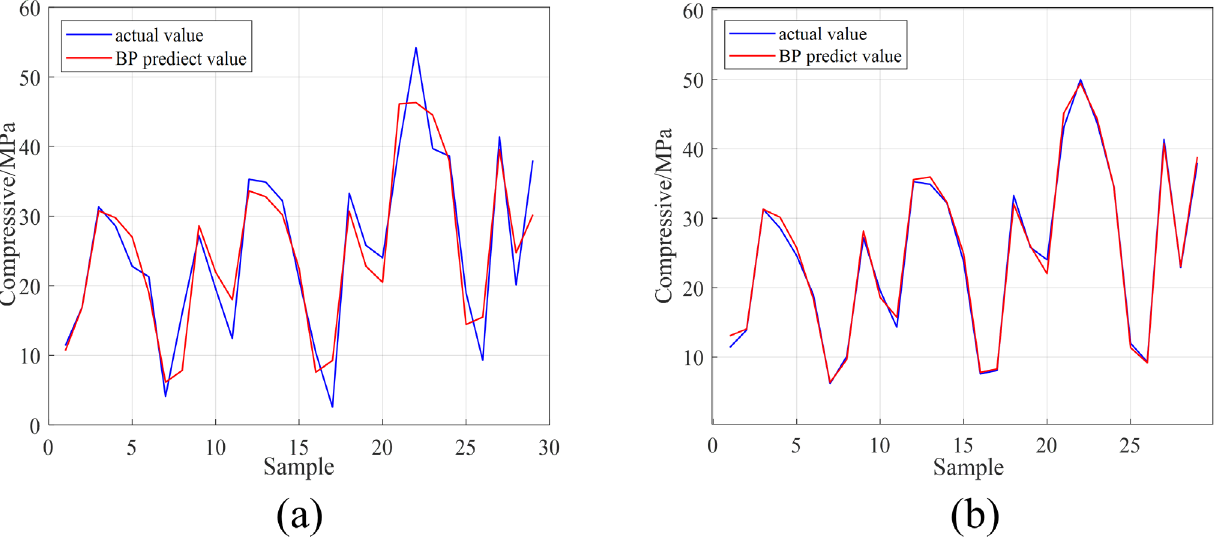
Figure 11. The actual value and the predict value of the test sets ( a ) the P-BR and ( b ) the AO-BR. Table 11. Evaluation metrics for test set of the P-BR and the AO-BR. MSE MAE